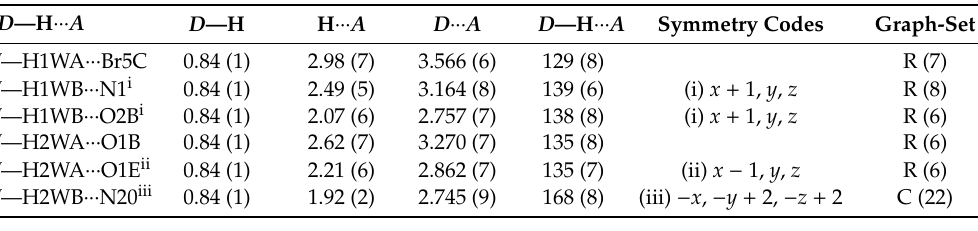
Figure 7. Packing of the molecules in the crystal of compound 1 along the b axis. The orange dots are disordered sites of Br atoms. Table 4. Hydrogen-bond geometry (Å, º) for compound 2. Table 4. Hydrogen-bond geometry (Å , º) for compound 2 .